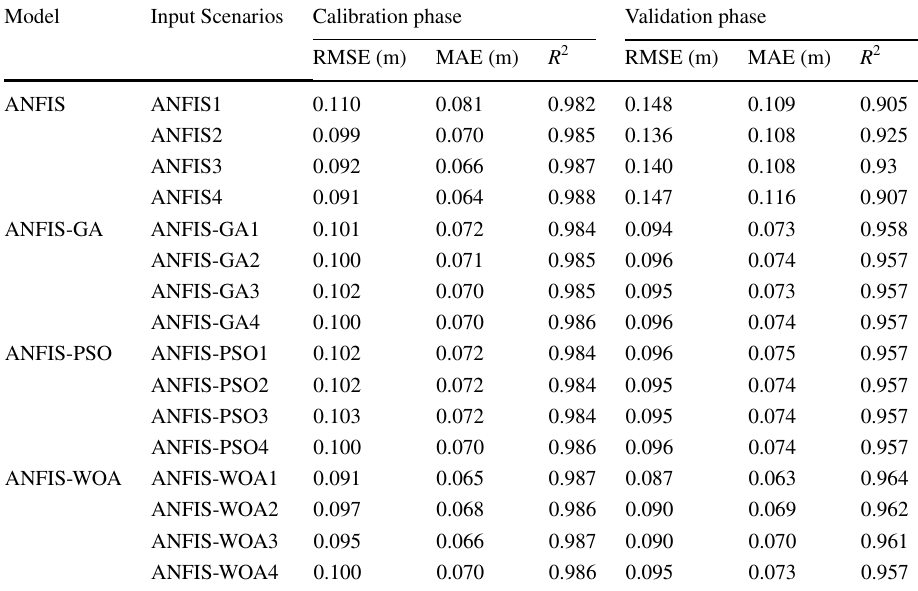
Table 3 Result of models' error